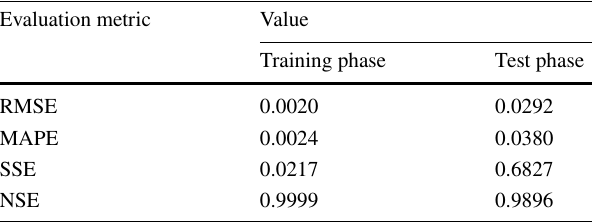
Table 5 Predictive capability of the light gradient boosting machine (LightGBM)